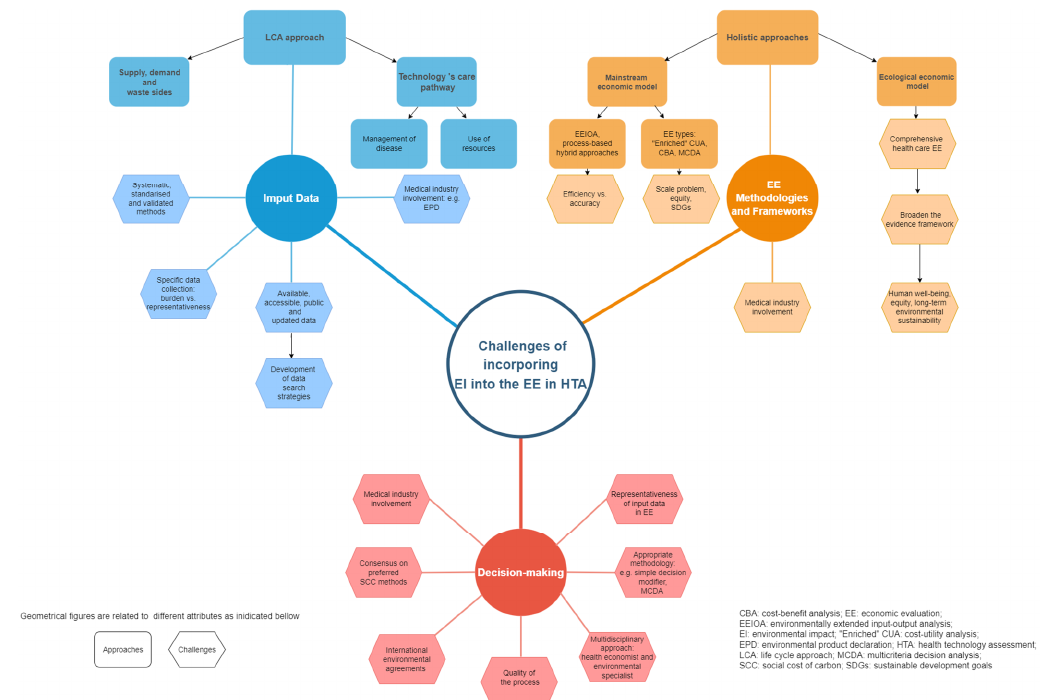
Figure 2. Challenges of incorporating environmental impact in the economic evaluation of health technology assessment [3,7,8,11–14,16–21,24,27,28,31–35,39,41,48,52–54]. The particular bibliographic references related to each approach and challenge can be found in sup- plementary material (Table S4)